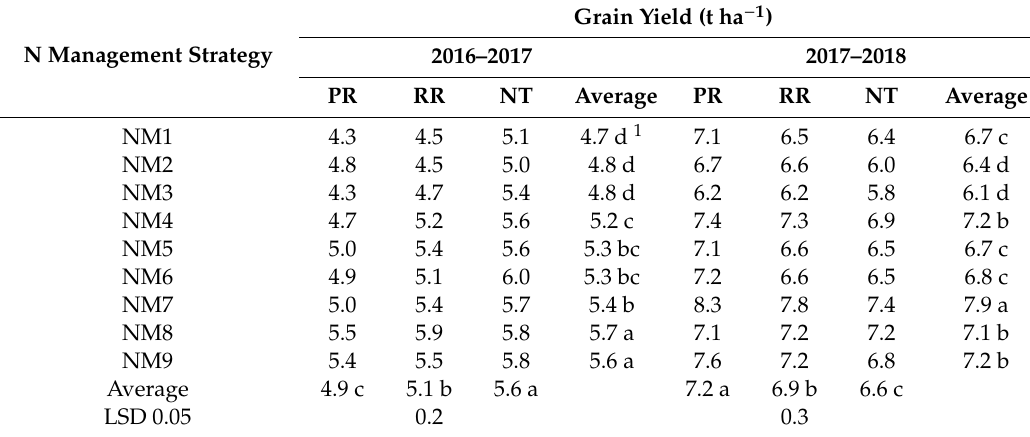
Table 4. Wheat grain yield under various tillage methods and N management strategies.